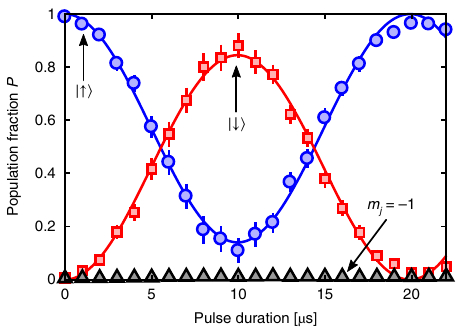
from the un-rotated "# ffiffiffi p 2 (shaded region), based on a fully QM > 3 þ 2 "#